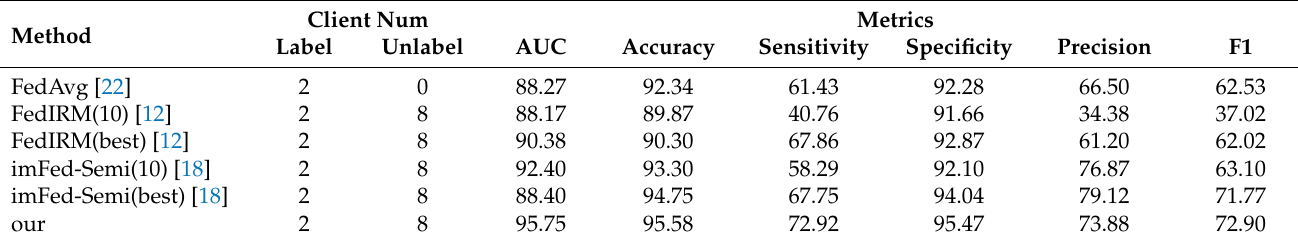
Table 1. Comparison with state-of-the-art methods on the same